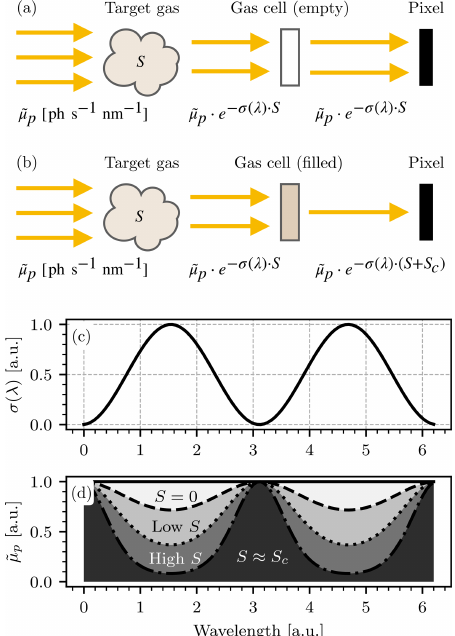
Figure 2. Schematic depiction of the absorption of incoming light in a GCS-based instrument. For simplicity only a single absorber is assumed. (a) The absorption scheme for the channel with the empty cell. (b) The absorption scheme for the channel with the filled cell. S denotes the column density of the target gas and S c the column density of the target species in the gas cell of the instrument. Pan- els (c) and (d) demonstrate the principle of GCS: given a hypo- thetical absorption cross section (here assumed to be of sinusoidal shape, displayed in c ), the spectral absorption can be derived from the Lambert–Beer law for different choices of S (here S = 0, “low S ”, “high S ”). A photosensor is only sensitive to the spectrally in- tegrated radiance that it is exposed to, i.e., the gray-colored areas displayed in (d)